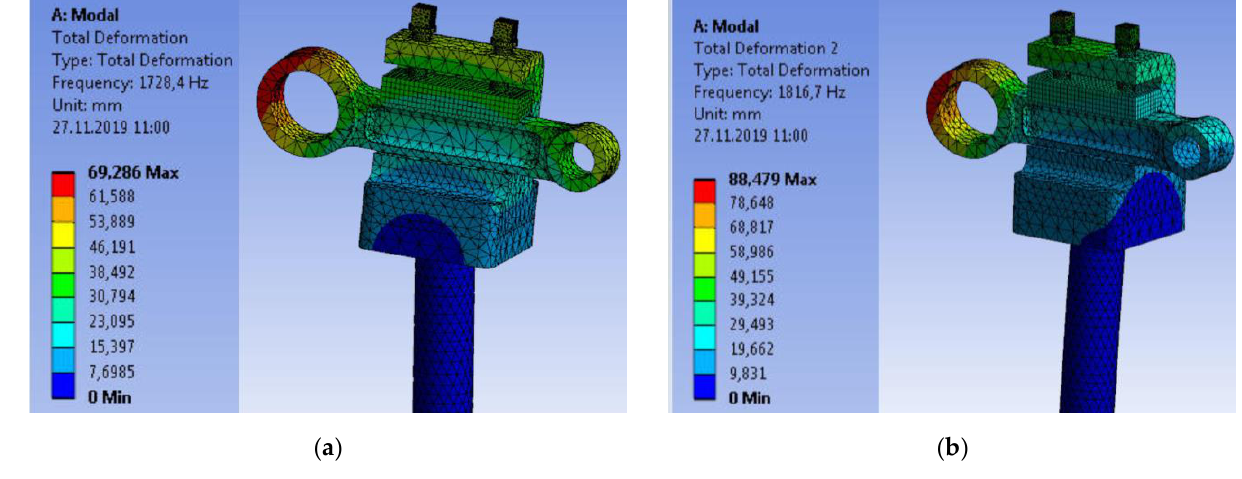
Figure 5. An example of the proposed fixture’s oscillation frequencies: ( a ) The 1st eigenfrequency; ( b ) The 2nd eigenfrequency.